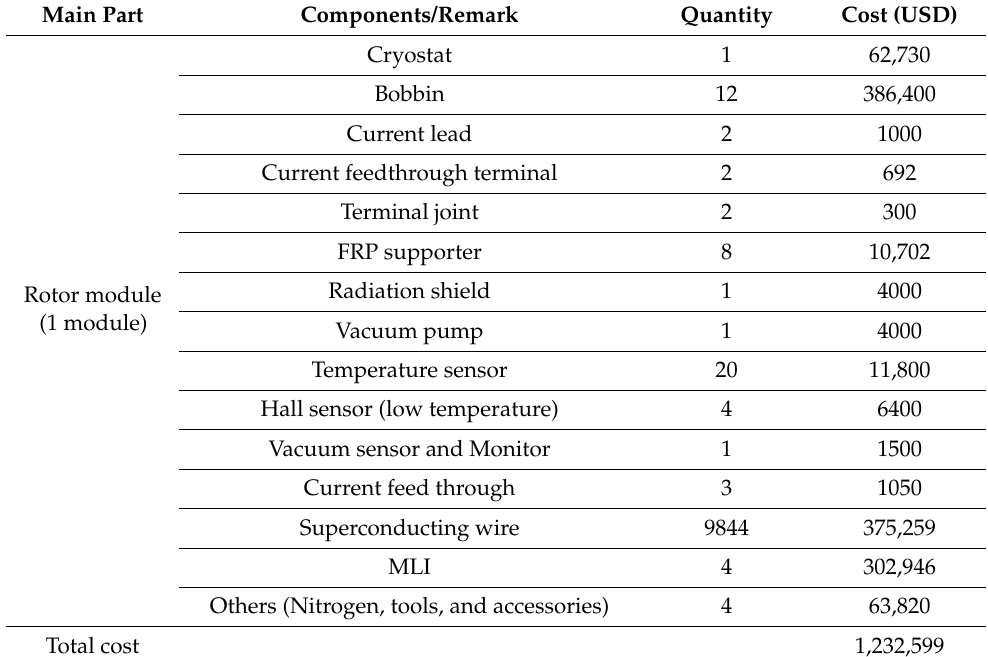
Table 2. Cost of one rotor module for 10 MW class SCSG.